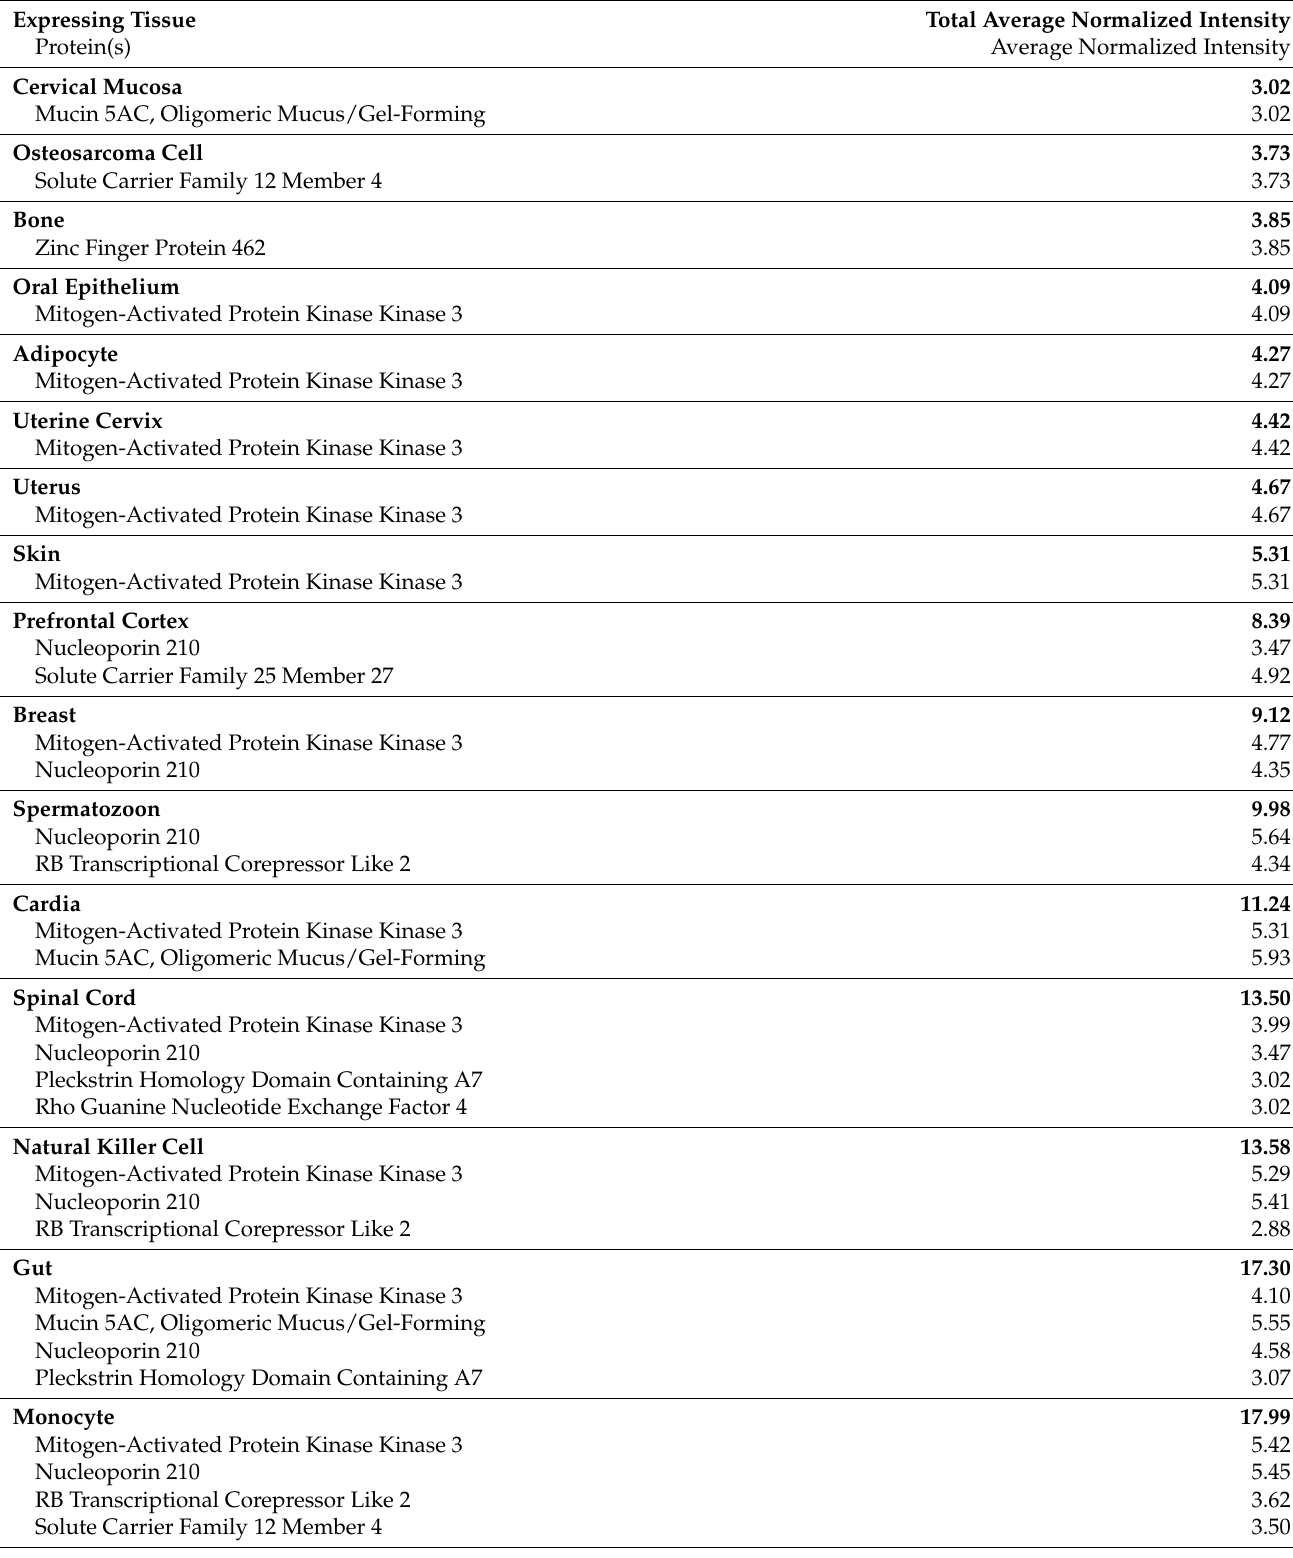
Table A3. Tissues expressing the identified proteins, in ascending order according to the total average normalized intensities. (Information retrieved from the resources detailed in the Materials and